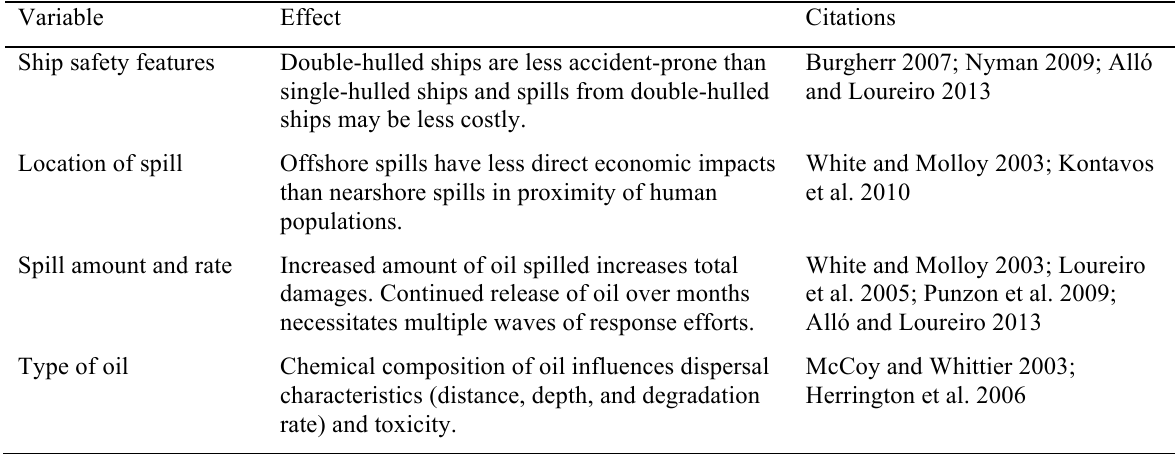
Table A1.1 Oil spill